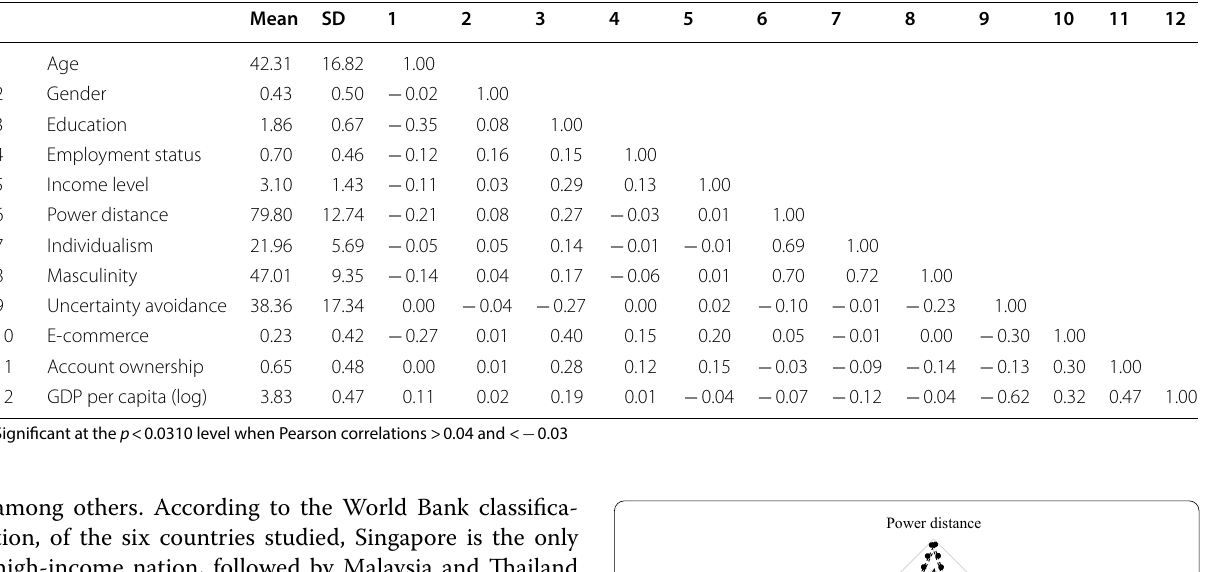
Table 2 Descriptive statistic and correlations